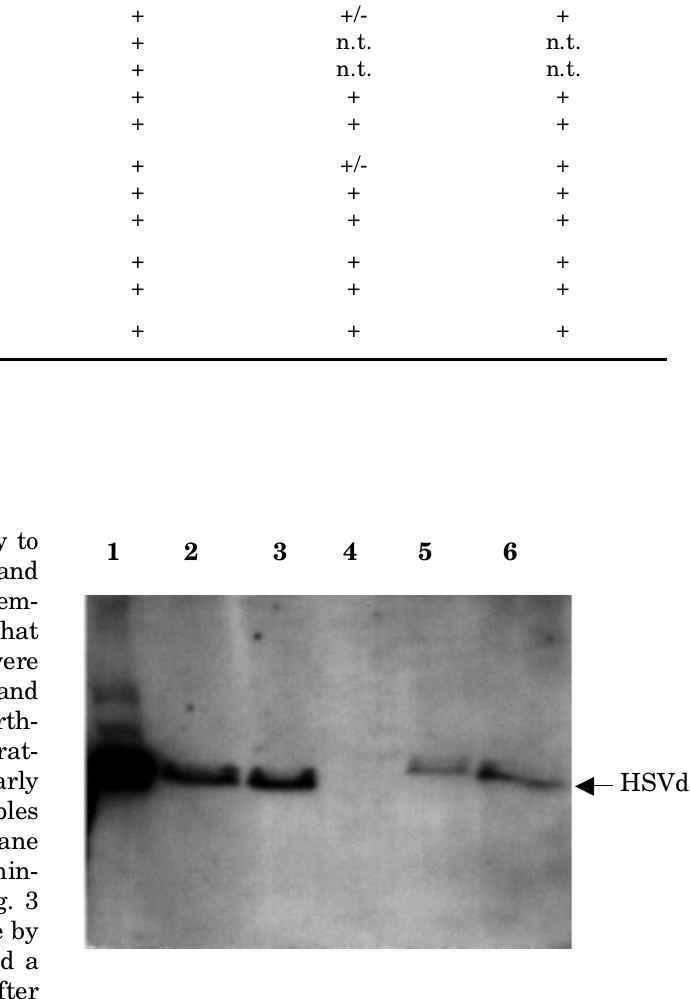
Table 2. HSVd-infected varieties and analysis methods used. Origin Variety